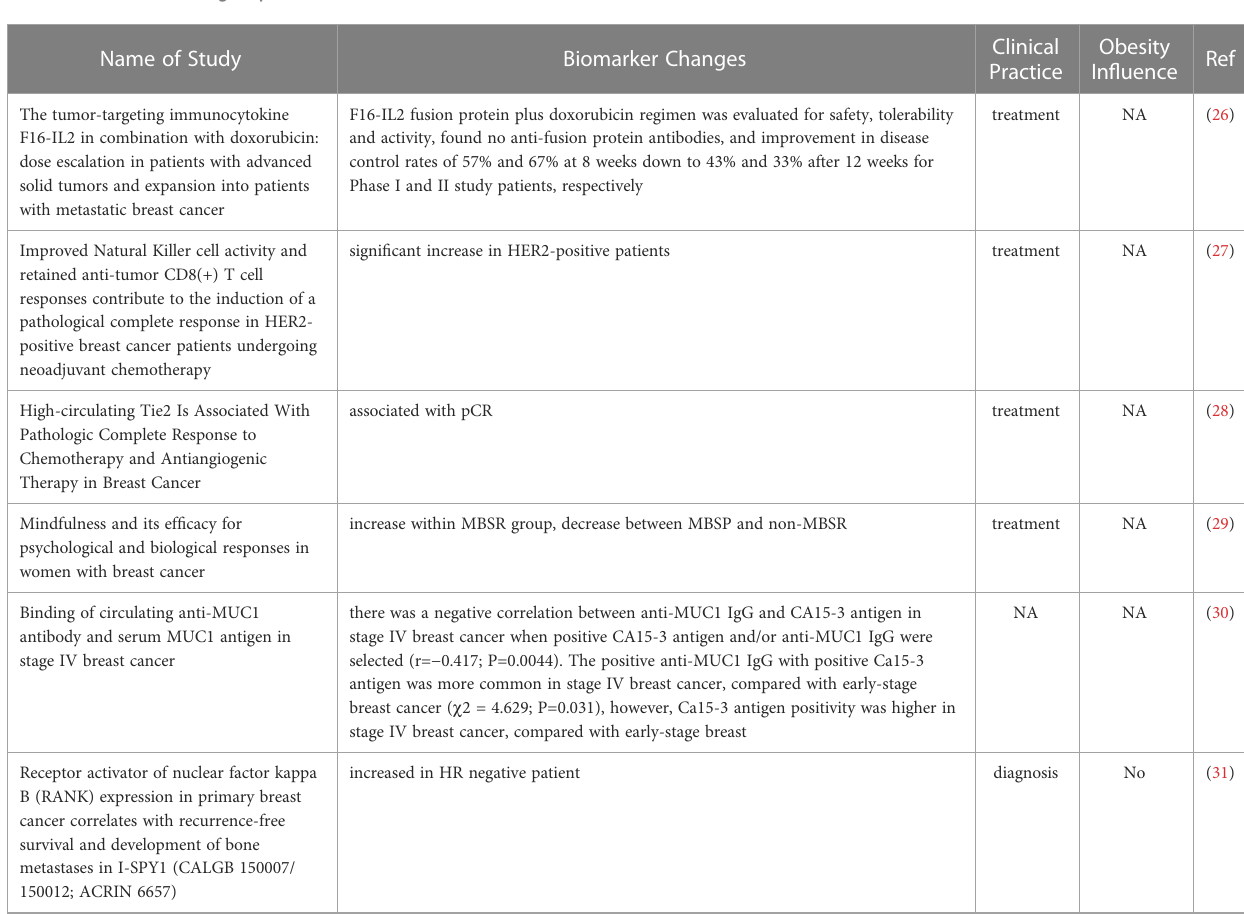
TABLE 3 Biomarker changes speci fi c to breast cancer.